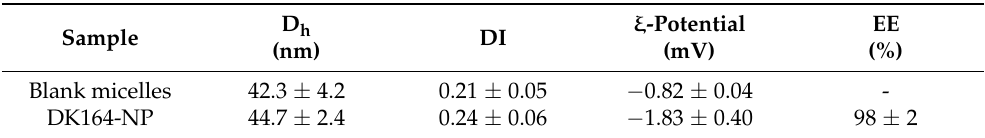
Table 1. Physicochemical characteristics of blank and DK164-loaded micelles prepared from PEO 113 -